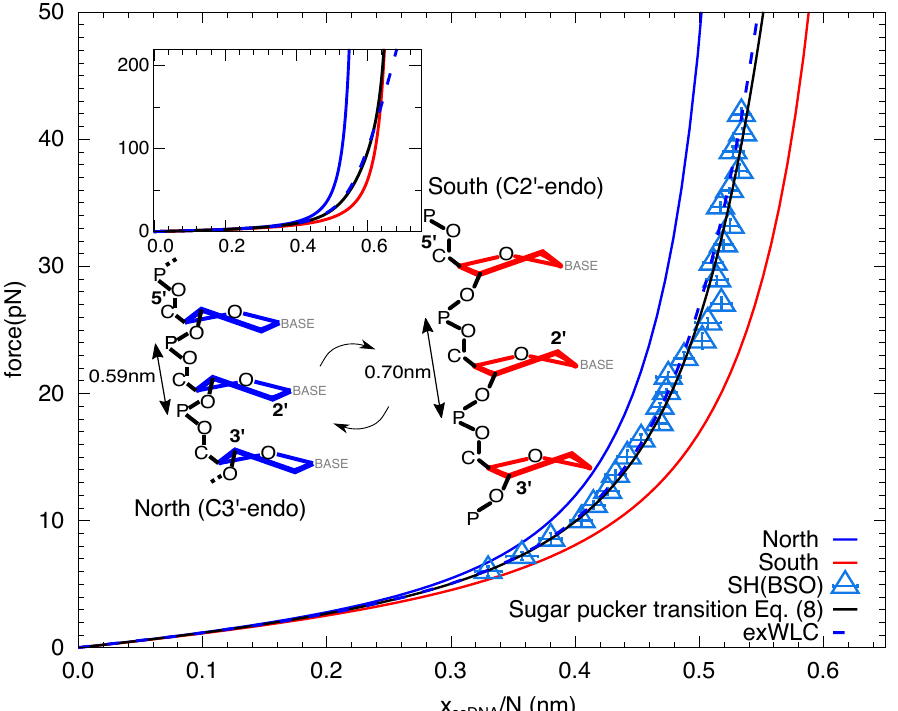
Figure 4. Sugar pucker transition. Prediction by the NS model Equation (2) (black line) compared to the extensible WLC (dashed blue line) fit to the FEC of SH, obtained the BSO method (empty blue triangles, also shown in Figure 3a). Blue and red lines correspond to the inextensible WLC FEC Equation (7) obtained by imposing the crystallographic contour length of the south and north configurations (schematic depiction shown), respectively, and the persistence lengths obtained from fitting the data to the NS model ( p S = 0.86 ( 4 ) nm and p N = 0.98 ( 4 ) nm, and a free energy of puckering per base of ∆ G pucker = 2 J = 0.38 ( 4 ) kcal/mol). The error of the fits are obtained from bootstrapping. (Inset) Same as in the main figure, but in a higher force range, showing that forces as high as 150 pN (all bases are in the south configuration) must be reached to see significant deviations from the NS model and the extensible